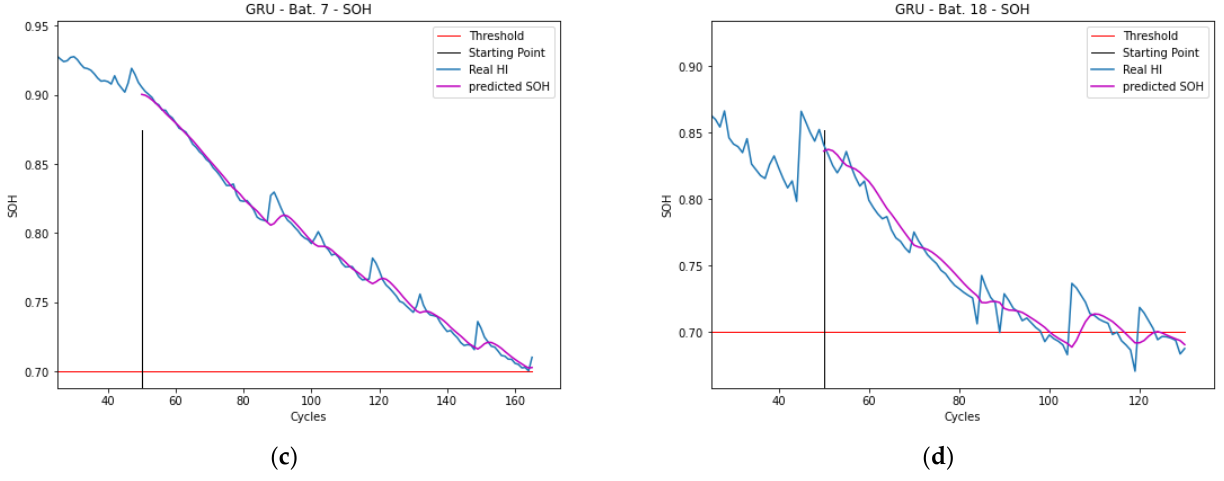
Figure 7. The SOH estimation result at starting point 0.3 for batteries ( a ) Bat. 5; ( b ) Bat. 6; ( c ) Bat. 7; ( d ) Bat. 18.